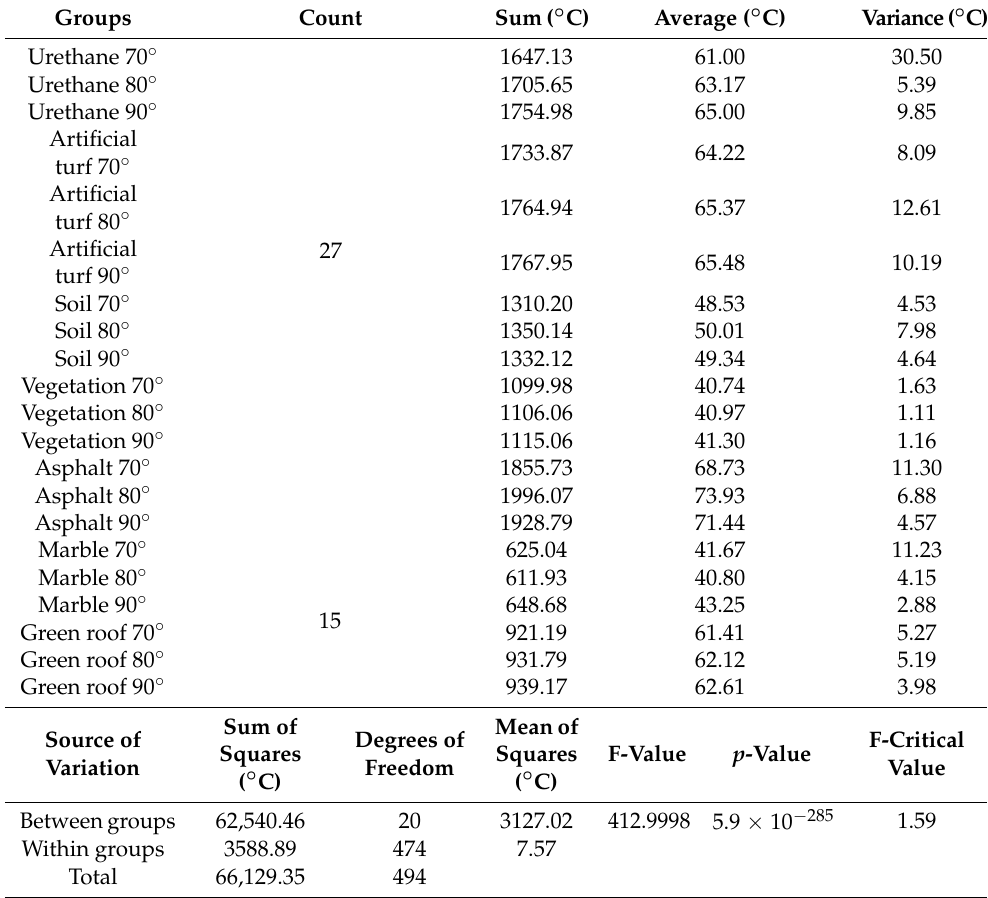
Table 8. ANOVA test to compare the difference in LST for each land cover according to the angle in study area B.